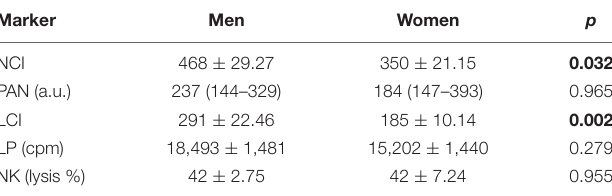
TABLE 3 | Immune status by